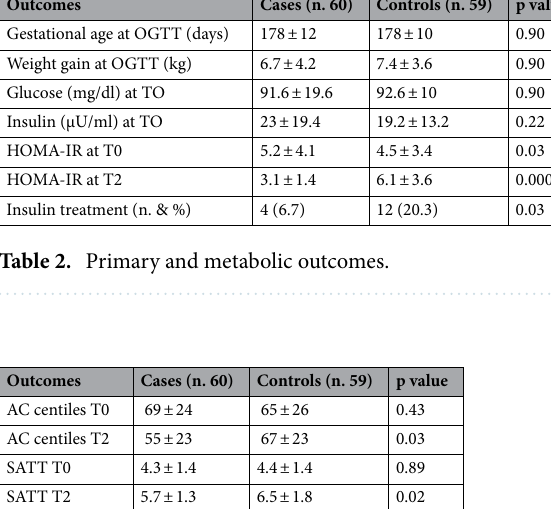
Table 3. Secondary outcomes. AC abdominal circumference, SATT subcutaneous adipose tissue thickness.